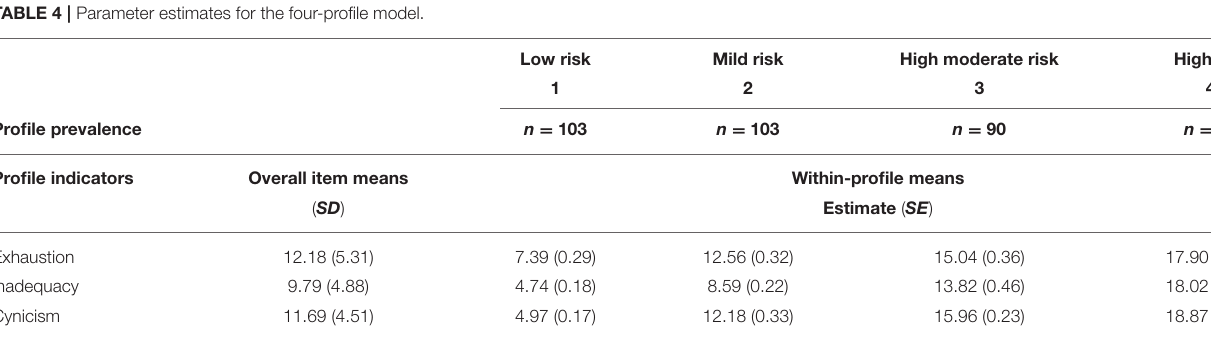
TABLE 4 | Parameter estimates for the four-profile